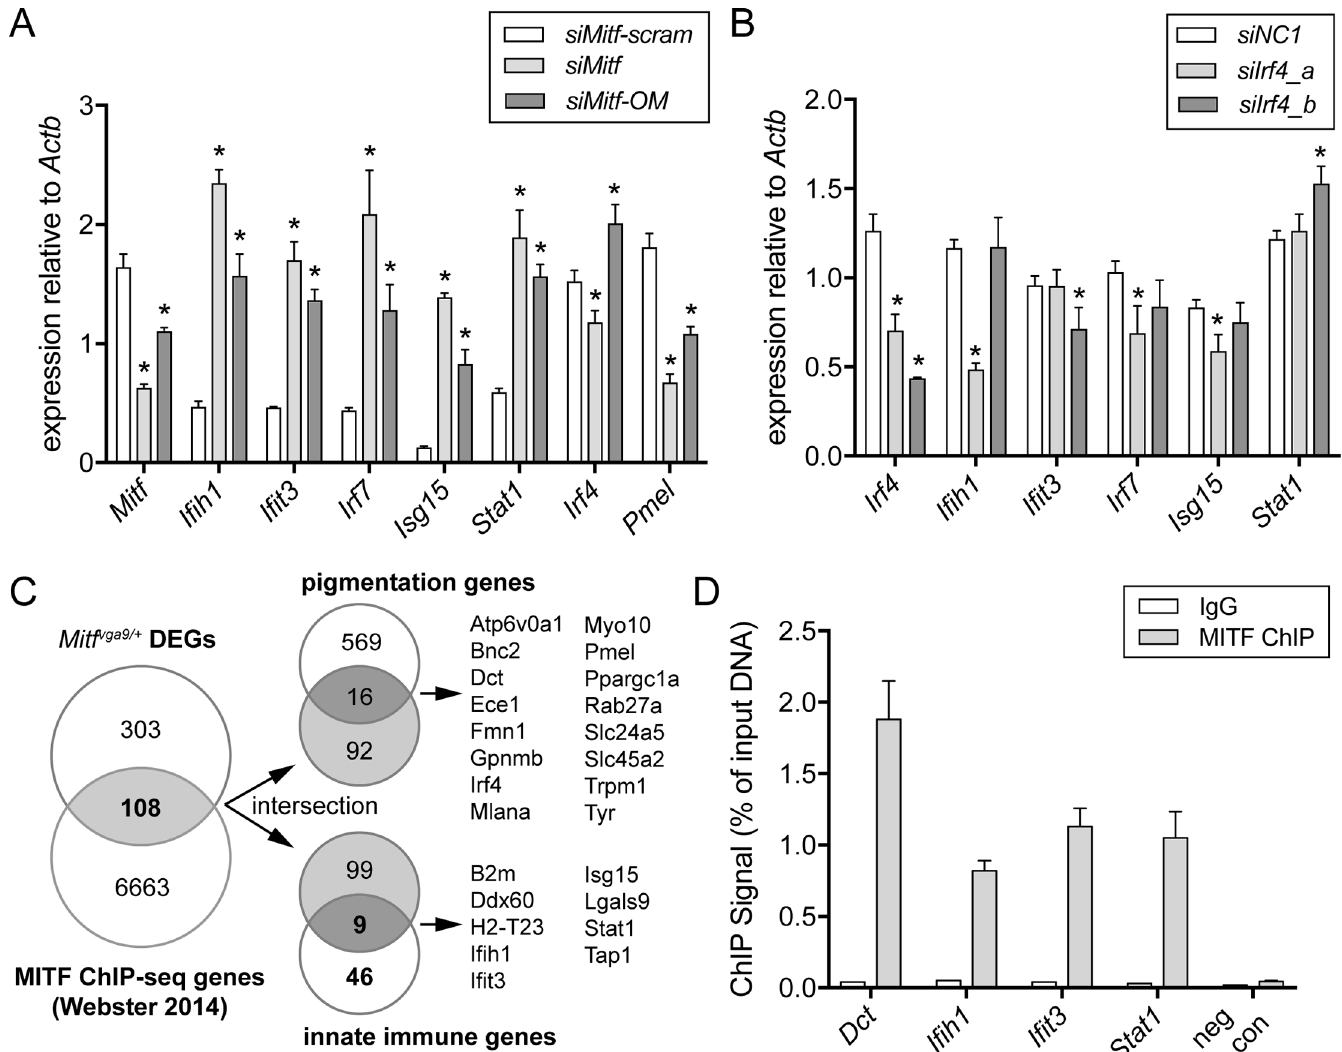
Fig 4. MITF binds to the promoter of innate immune target genes and acts as a transcriptional repressor. (A, B) Relative gene expression in melan-a cells 48 hours after transfection with siRNA. In (A) ,cells were transfected with siRNAs targeting Mitf ( siMitf and siMitf-OM ) or an analogous scrambled control siRNA ( siMitf-scram ). In (B) , cells were transfected with one of two siRNAs targeting Irf4 ( siIrf4_a , siIrf4_b )or siNC1 .The bars represent the mean ± standard deviation, and the asterisks indicate gene expression changes with a q -valueof < 0.05 using the two-stage linear step-up procedure of Benjamini, Krieger, and Yekutieli, with Q = 5%. Data presented in A and B are representative of two independent knockdown experiments performed in melan-a cells at two different cell passages. (C) Venn diagrams demonstrating the intersection of gene lists. The left diagram represents the genes exhibiting a 1.5-fold or greater differencein expression in Mitf mi-vga9/+ over wild-type McSCs ( Mitf mi-vga9/+ DEGs, top circle) overlapped with the list of genes associated with MITF ChIP-seq peaks reported by Webster et al. 2014 (MITF ChIP-seq genes, bottom circle) [41]and are considered potential direct targetsof MITF. These 108 direct targets are provided in S4 Data .Direct target genes were further identified by comparing them with a list of known pigmentation genes in the upper right diagram and with the list of 55 innate immune-related genes up-regulated in Mitf mi-vga9/+ McSCs (as defined in Fig 3A)in the lower right diagram. (D) MITF ChIP-qPCR performed in melan-acells and assayed for enrichmentat the indicated gene loci ( Dct , Ifih1 , Ifit3 , Stat1 ).A centromeric DNA sequence was amplified as a negativecontrol (neg con). Error bars indicate mean ± standard deviation of two independent ChIP pulldowns. The raw data used to generate the graphs in (A), (B), and (D) are available in S1 Data . Actb , actin beta; ChIP, chromatin immunoprecipitation; ChIP-qPCR, chromatin immunoprecipitation quantitative polymerase chain reaction; ChIP-seq, chromatin immunoprecipitation sequencing; DEG, differentially expressed gene; IgG, immunoglobulin G; McSC, melanocyte stem cell; MITF, melanogenesis associated transcription factor; neg con, negative control; siNC1 ,nontargeting control siRNA; siRNA, small interfering RNA.